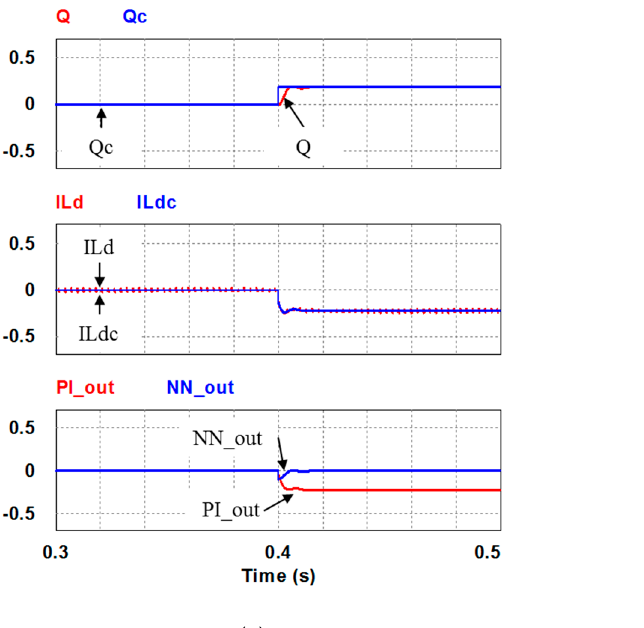
Figure 20. Case 2 simulation result: ( a ) reactive power feedback and its command, inductor current power and its com- mand, and reactive power controller outputs (all control signals are in V); ( b ) accumulated reactive power control error.